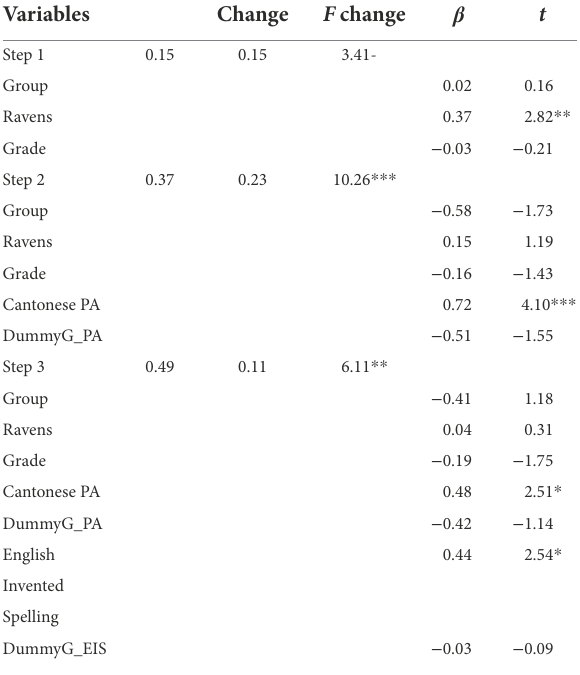
TABLE 4 Summary of hierarchical regression predicting Mandarin Pinyin Invented Spelling of L1 and L2 Chinese speaking